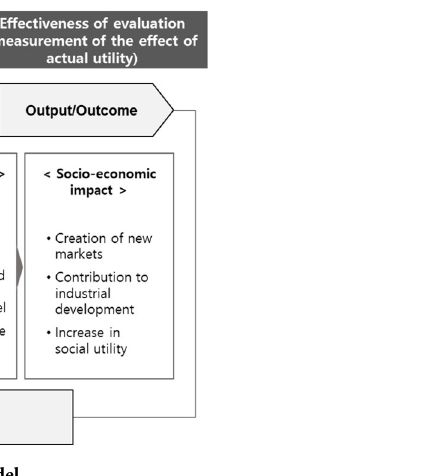
Fig 2. Utility evaluation factors with IPO logic